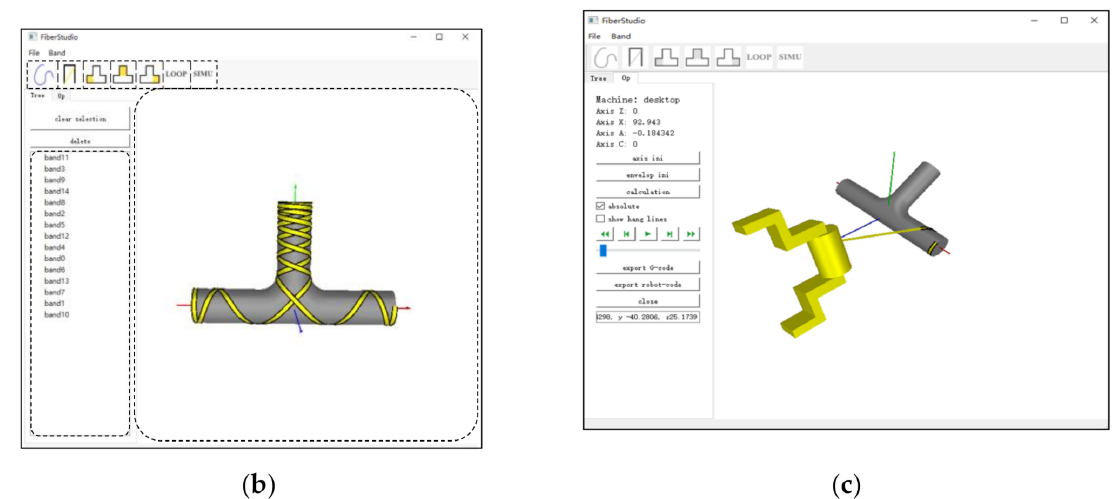
Figure 11. CAD/CAM software: ( a ) FiberStudio’s frame; ( b ) CAD/CAM user interface; ( c ) Simulation of the winding